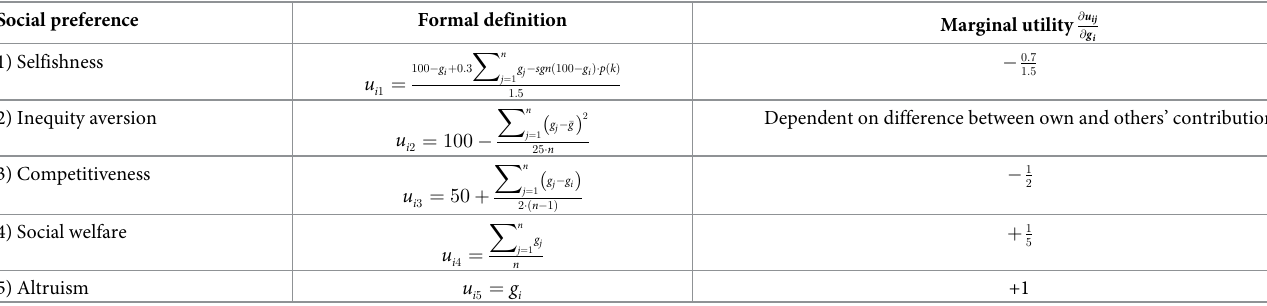
Table 2. Formal definitions of social preferences and their marginal